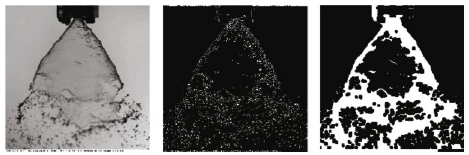
Figure 4: Extraction of the spray cone